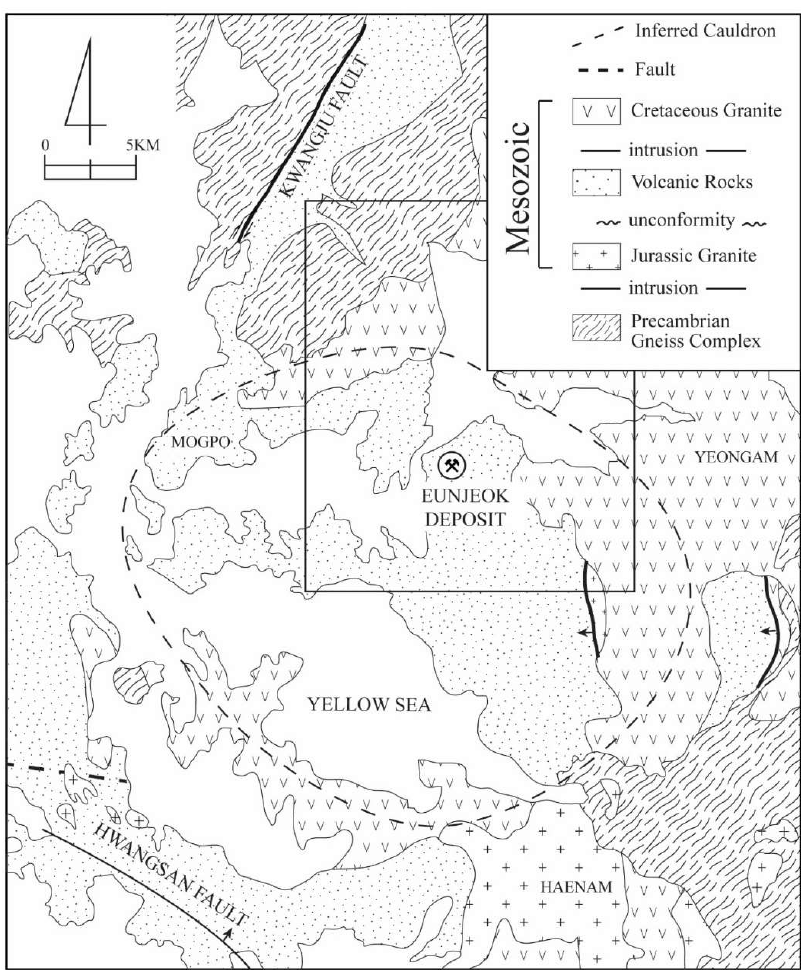
Figure 2. Regional geologic map including the Eunjeok deposit district modified from [11].